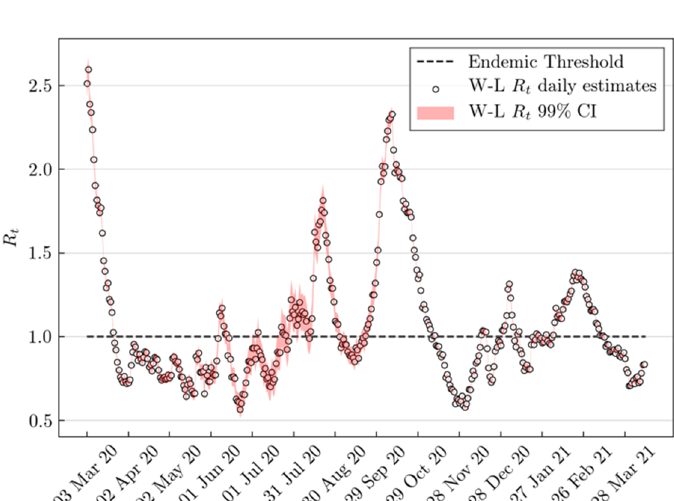
Figure 1. Wallinga–Lipsitch estimates. Wallinga–Lipsitch R t estimates in Lombardy (black circles) and their 99% CI (red shape) from 3 March 2020 to 11 April 2021. The endemic threshold, corresponding to R t = 1, is depicted through a dashed black